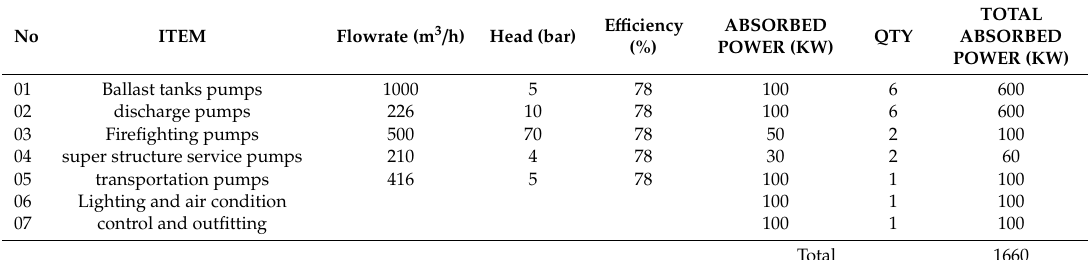
Table 3. Power consumption of marine service units per hour.